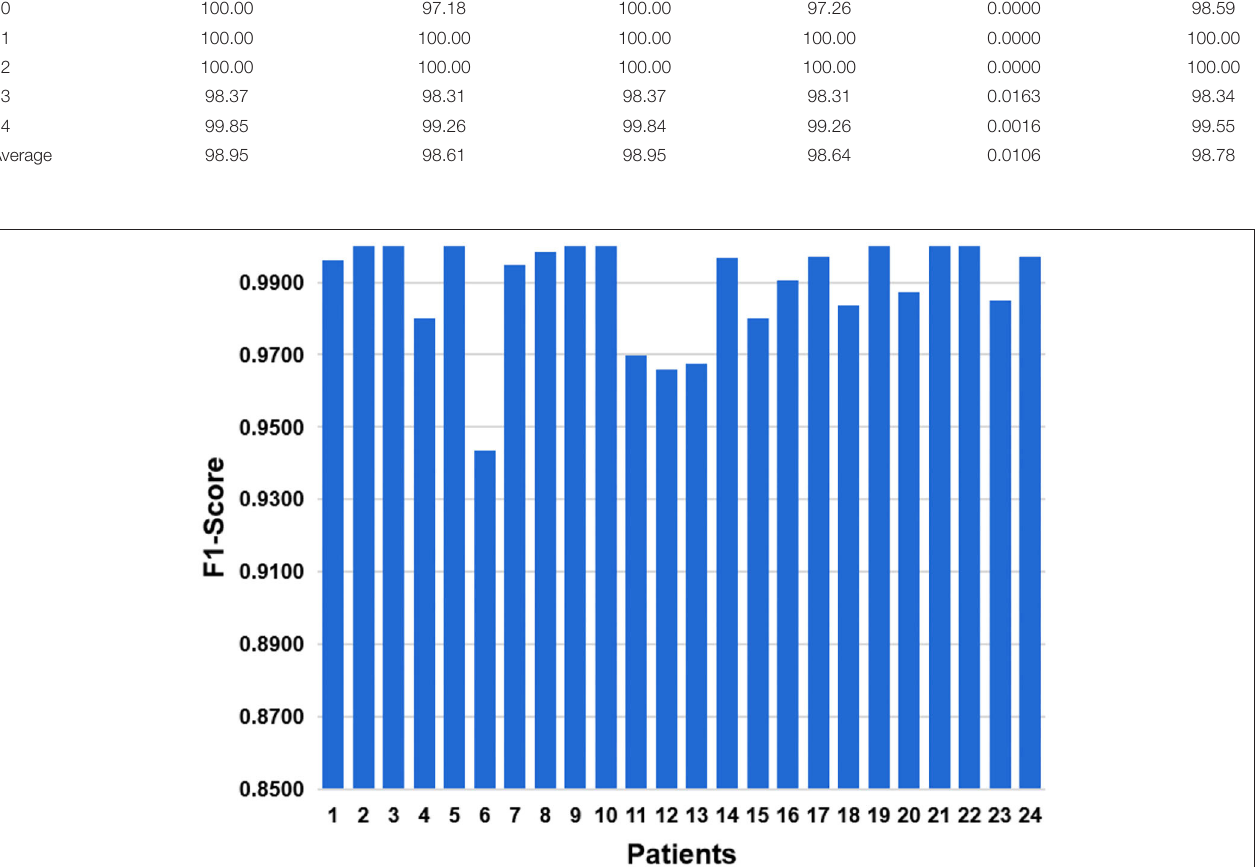
FIGURE 13 | In order to balance influences of precision and recall, we have added F1-Score indicator.